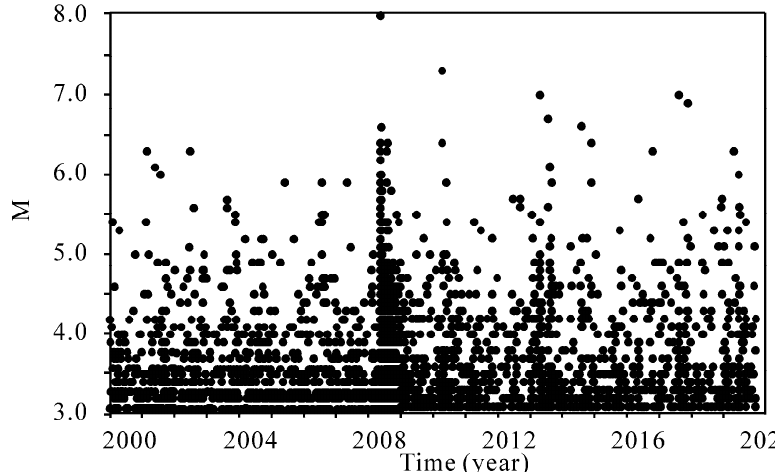
Figure 9. Scatter plot of magnitude relative to the sequential number of events in this study area.